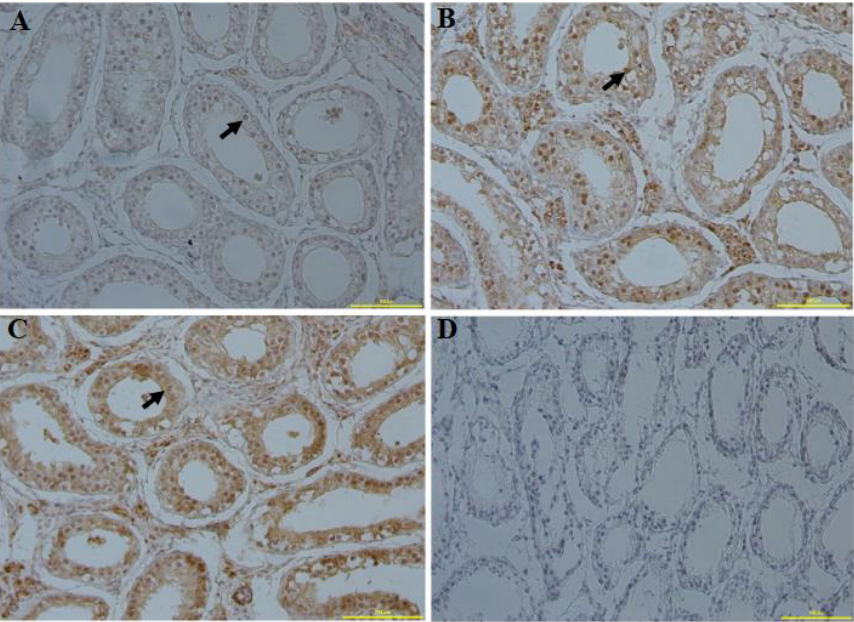
Figure 3. The immunohistochemical staining of tissue section from Murrah buffalo testis for the localization of PHB (a), CAPZB (b), TEKT2 (c) and testis negative control (d). PHB, prohibitin; CAPZB, capping actin protein of muscle Z-line beta subunit; TEKT2, tektin-2. Bar, 100 μm.